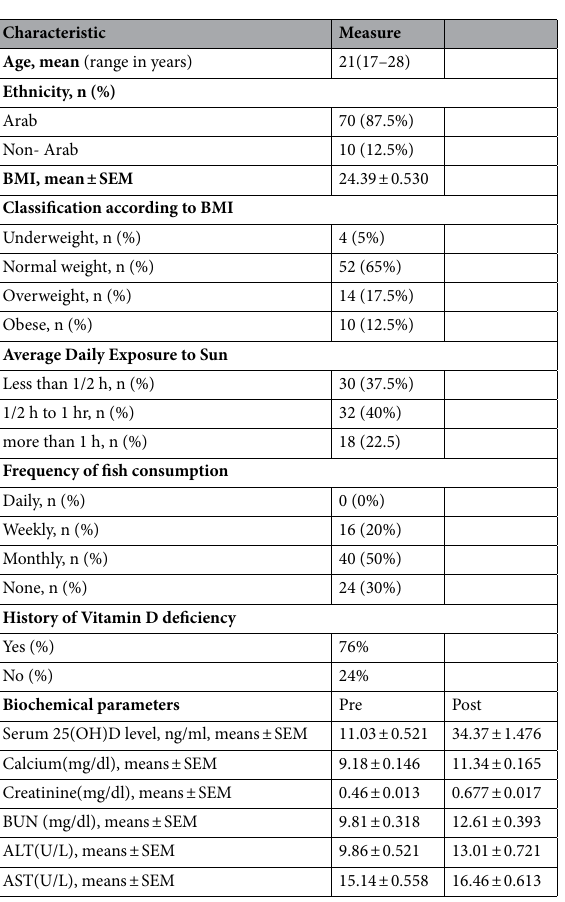
Table 1. Baseline Characteristics of Study Participants. SEM, Standard error of measurement; BMI, Body mass index; BUN, blood urea nitrogen; ALT, alanine aminotransferase; AST, aspartate